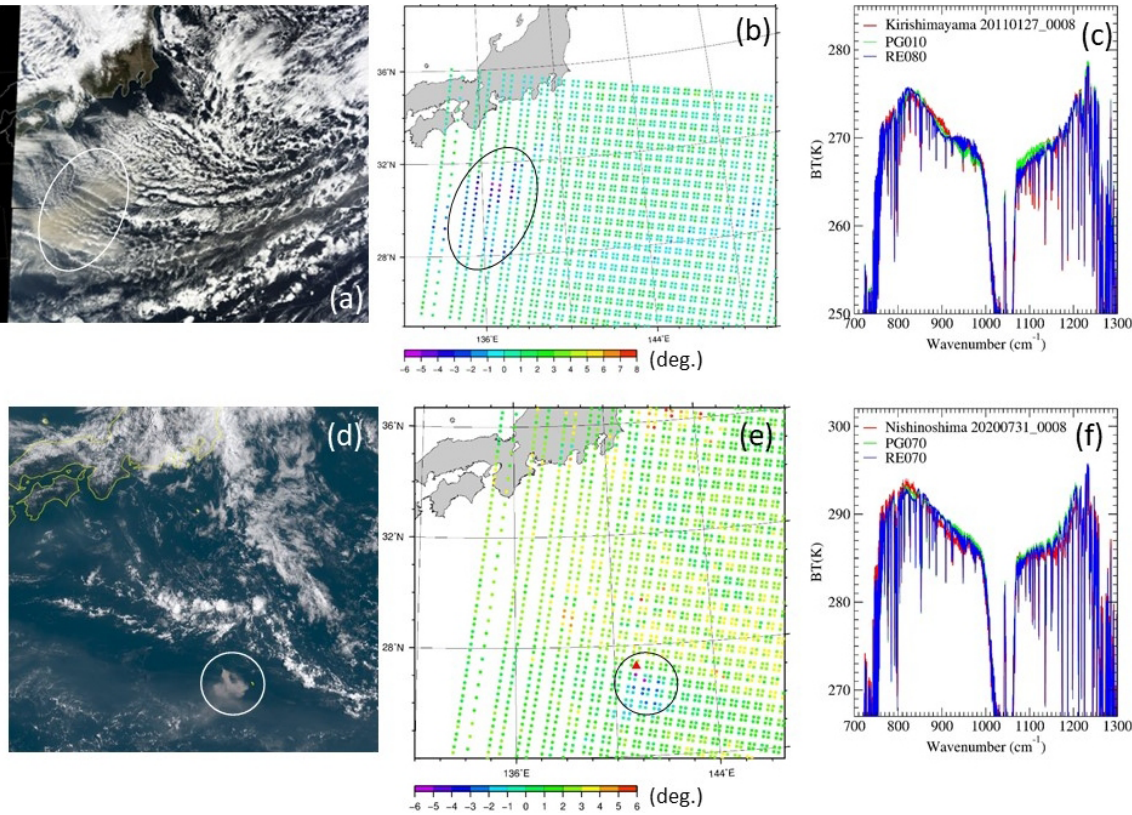
Figure 14. (a–c) Composite MODIS image of the Kirishimayama VAC at 01:05UTC on 27 January 2011 (a) , and (cid:49) BT split from IASI data at 00:08UTC on the same day (b) . Results of BTS simulations for the pixel at (lat, long) = (31.079 ◦ N, 136.500 ◦ E) and the measured values are shown in (c) . The RI models PG010 (green) and RE080 (blue) were used for the BTS simulations. For the Nishinoshima VAC on 31 July 2020, the visible true-color image (d) is from the Himawari-8/AHI observation at 00:00–00:09UTC, and (cid:49) TB split is from IASI at 00:05–00:08UTC (e) . (f) Measured and calculated BTS for the pixel at (lat, long) = (26.719 ◦ N, 141.167 ◦ E). The RI models PG070 (green) and RE070 (blue) were used for